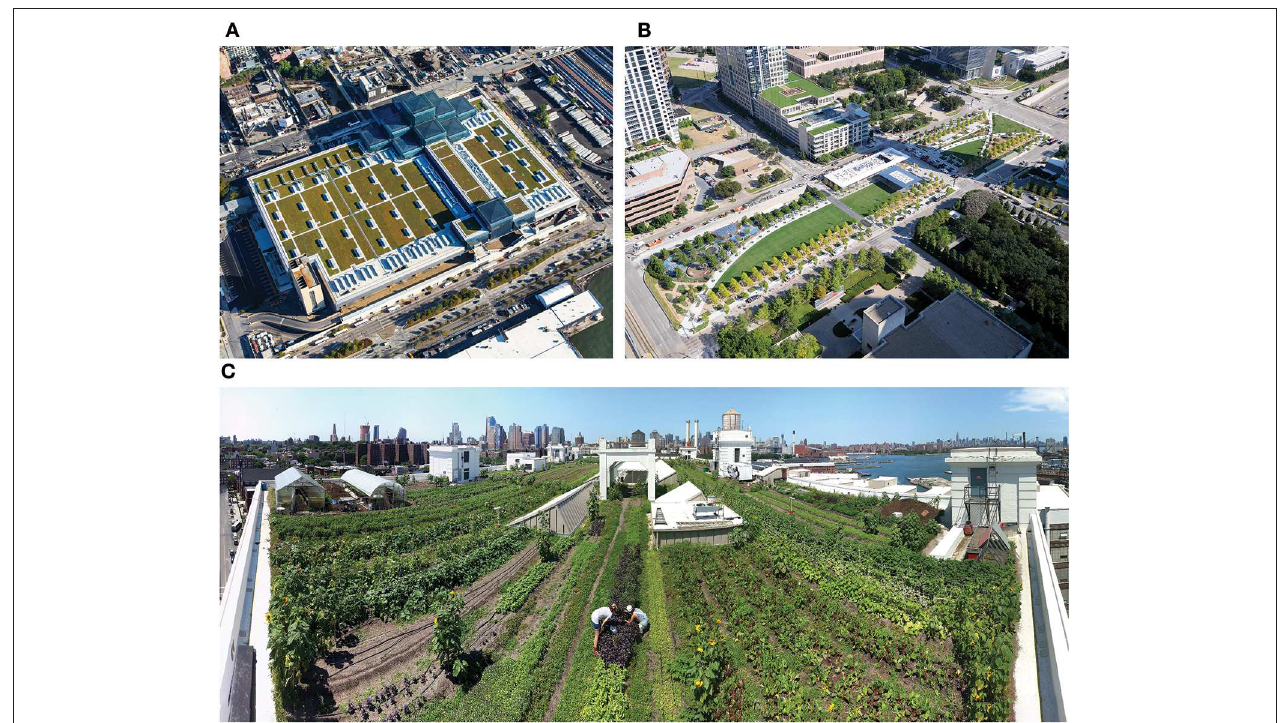
FIGURE 1 | Examples of constructed ecosystems on built surfaces. (A) A 2.7-hectare green roof growing drought-tolerant sedum species on the Javits Center in New York City, New York (Image © Javits Center). (B) Klyde Warren Park: a 2.1-hectar public park, growing trees, shrubs, lawns, and ornamental herbs on the capping structure over Woodall Rodgers Freeway in Dallas, Texas (Image © OJB Landscape Architecture). (C) The Brooklyn Grange: a 0.6-hectar rooftop farm growing vegetables on top of an 11-story building in the former Brooklyn Navy Yard in New York City, New